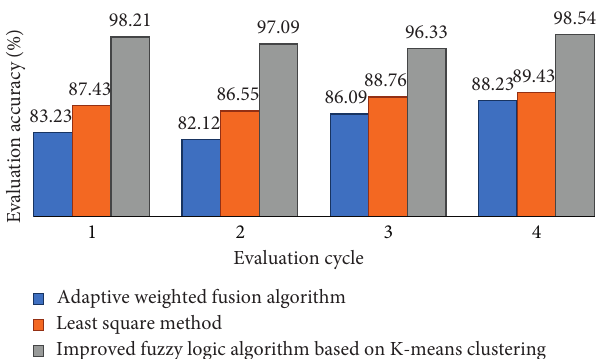
Figure 5: Evaluation accuracy of performance test. Table 2: Performance test comparison.